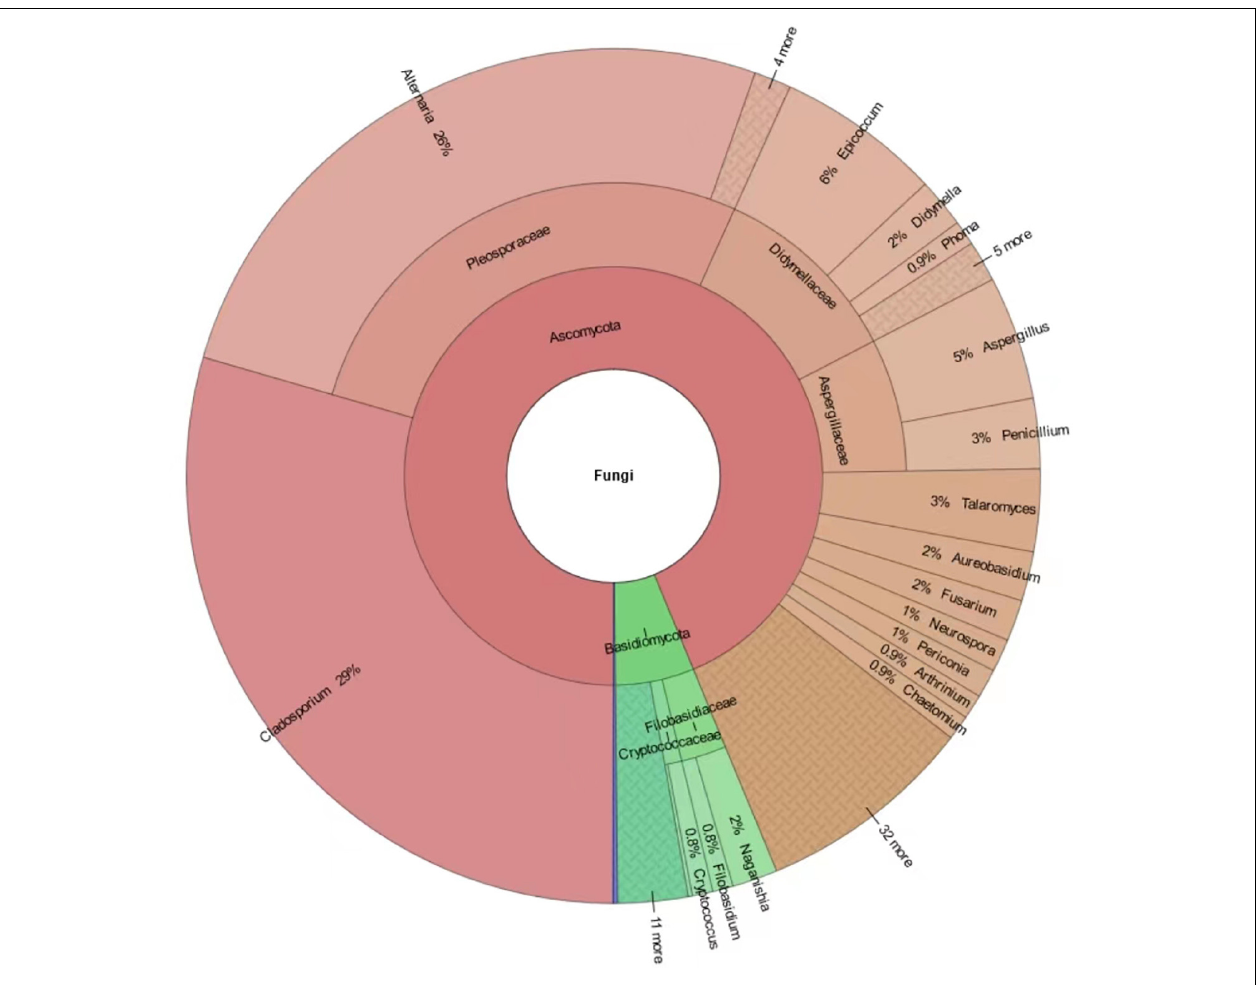
FIGURE 5 | Krona chart indicating the taxonomic diversity and relative abundance of fungi isolated in this study. Round values are